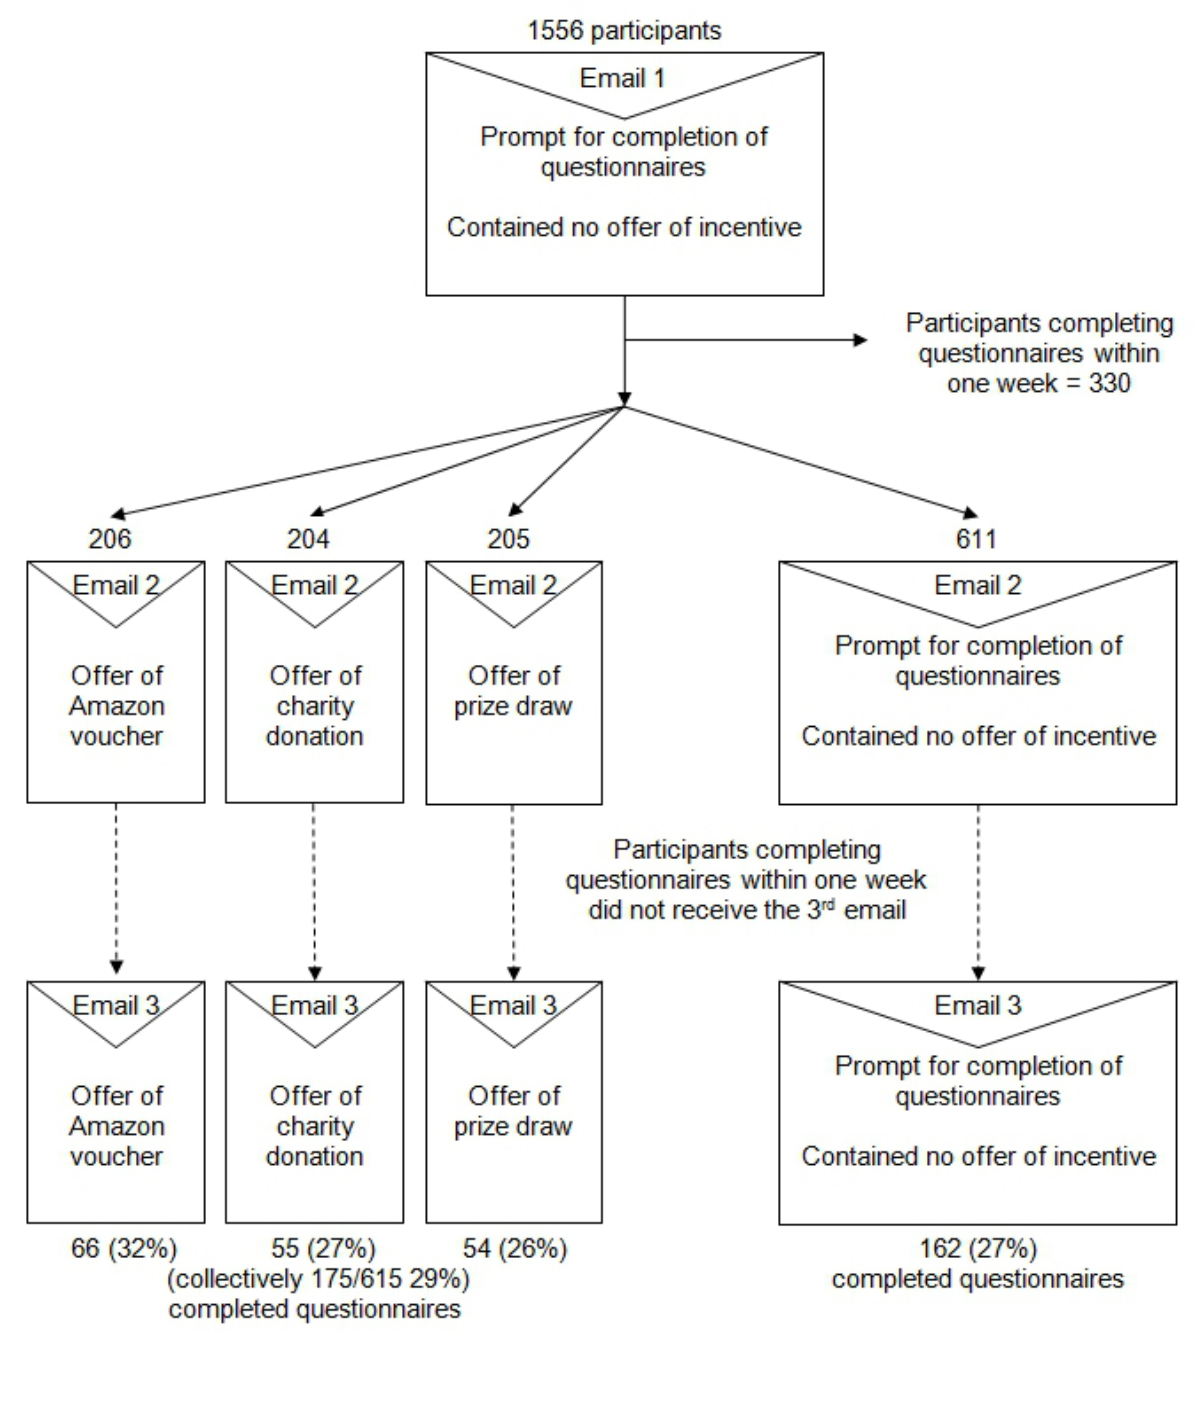
Figure 1. Consolidated Standards of Reporting Trials (CONSORT) flowchart: study